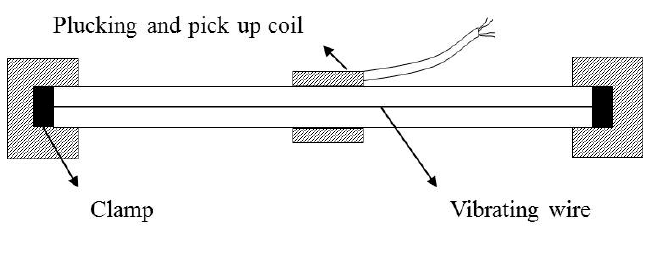
Figure 3. Vibrating wire strain